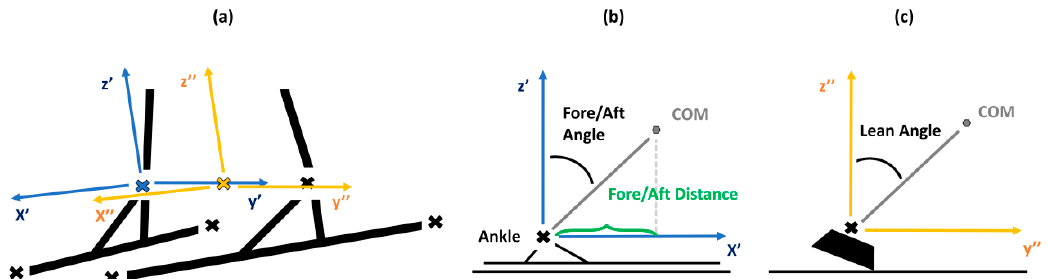
Figure 3. Definitions of the fore / aft position ( d Fore / Aft ) and the lean angle ( λ Lean ). ( a ) Local coordinate systems are defined relative to the ski and up direction. ( b ) The fore / aft position is the projection of the COM on the x’ axis. ( c ) The lean angle is the orientation of COM in the x”-y”